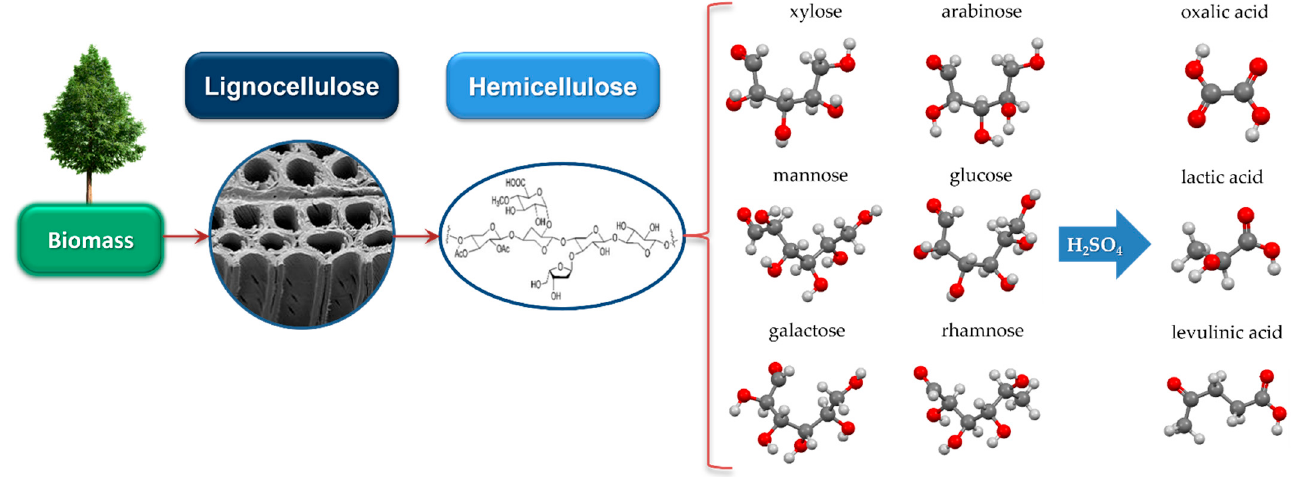
Figure 1. Scheme of mixtures of biomass ‐ derived hemicellulose carbohydrates obtained from OrganoCat technology.